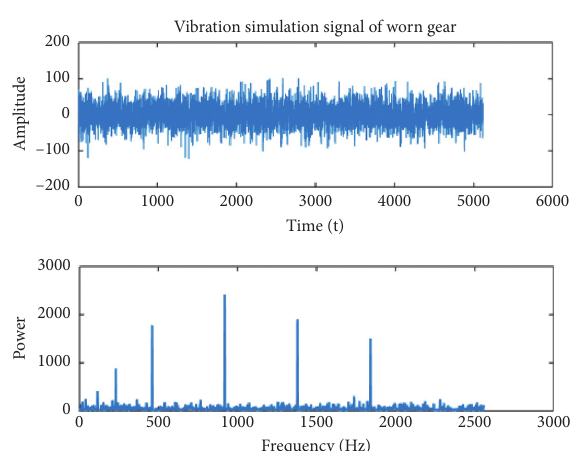
Figure 3: Vibration simulation signal of worn gear.